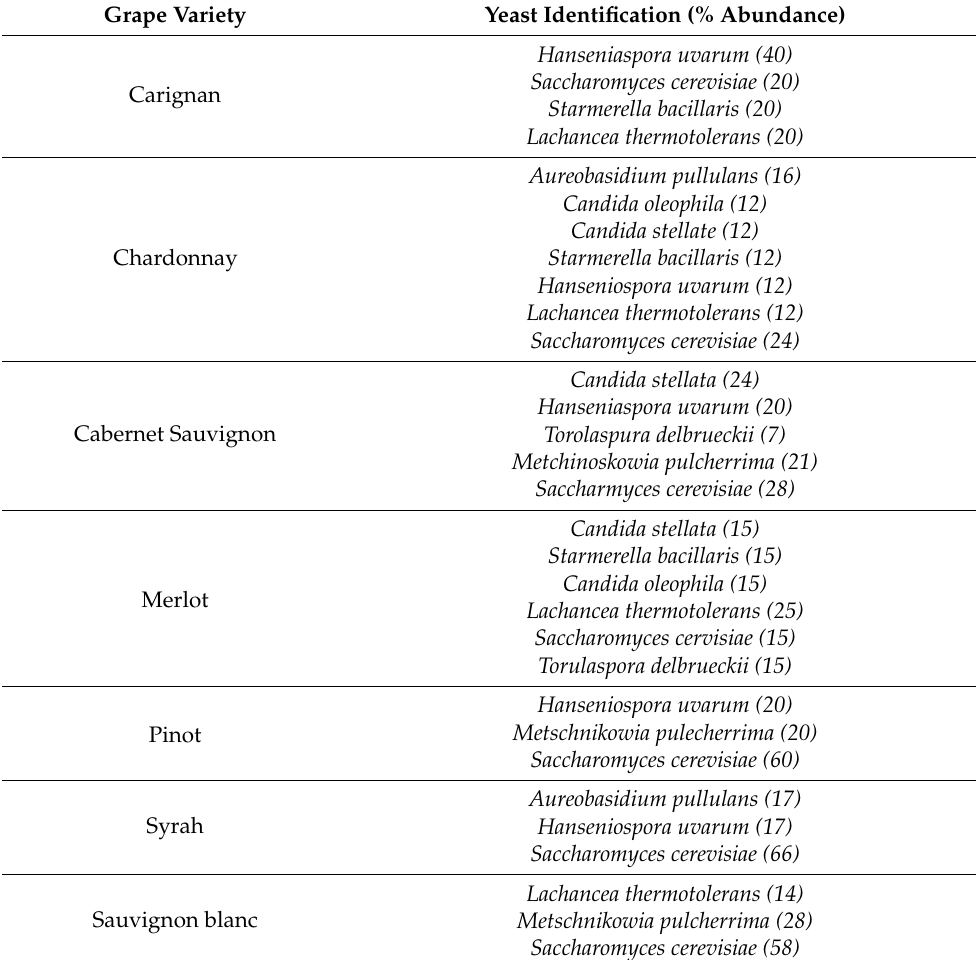
Table 2. Identification of the yeast species found on day 7 of spontaneous fermentation. These species were obtained from isolated colonies that presented a different and unique morphology, which was later identified with 26S rRNA